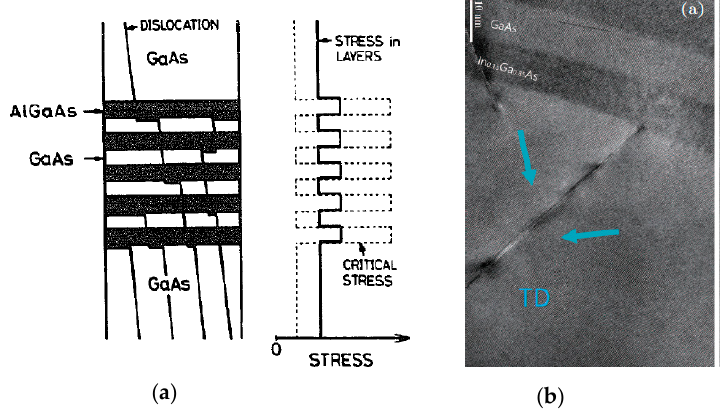
Figure 46. ( a ) Reduction of threading dislocation density (TDD) at layer interfaces in a superlattice (SL). Dislocations are bent at the interfaces in SL [321], and ( b ) a TEM image of a part of a SL structure with GaAs bu ff er layer grown by LT / HT multi-steps epitaxy [324]. The TEM image shows the TDs are restricted at InGaAs / GaAs interface and do not propagate further in the same